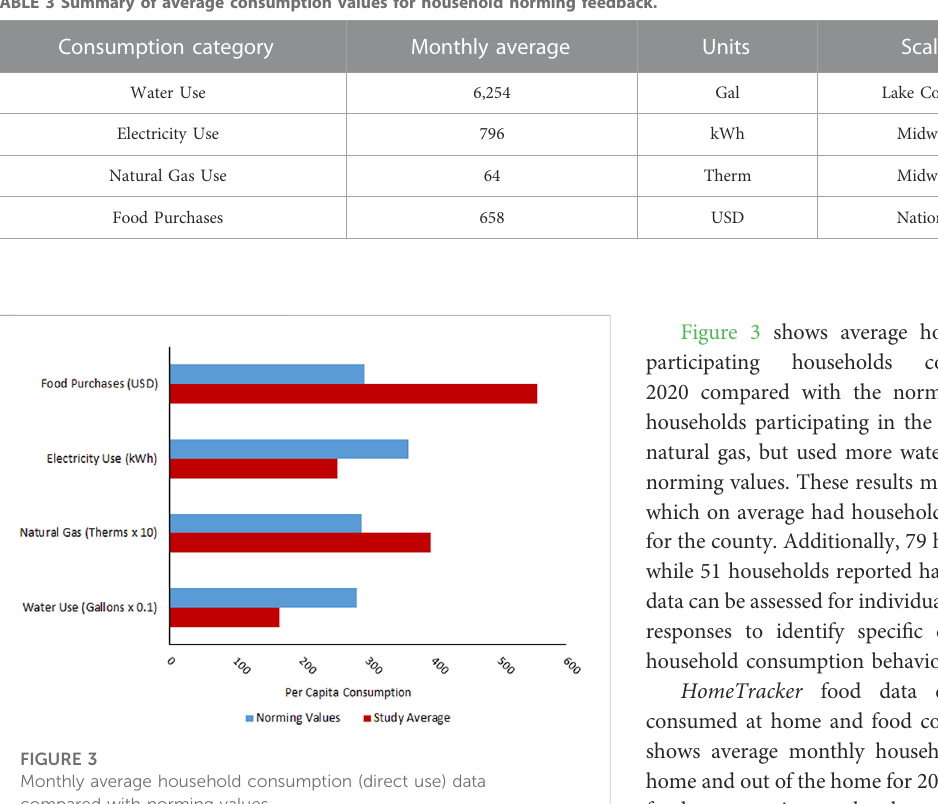
FIGURE 3 Monthly average household consumption (direct use) data compared with norming